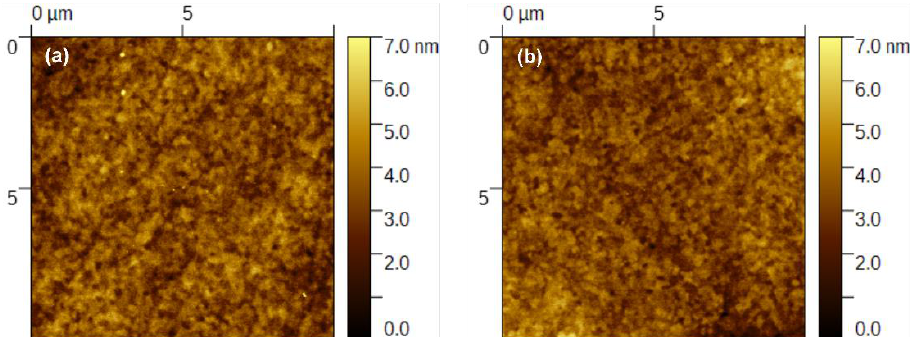
Figure 7. AFM topology of emissive layers (PVK + 25 wt.% SpiroAC-TRZ + 2 wt.% Ir) prepared by means of spin coating ( a ) and slot-die coating ( b ) techniques. Emissive layer deposited on PE- DOT:PSS/ITO.